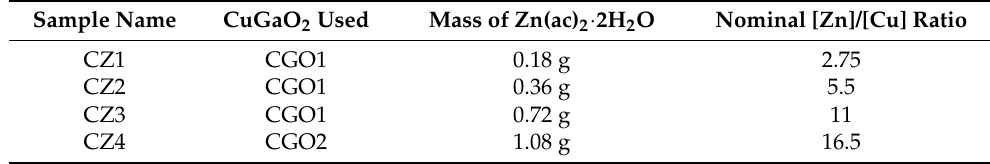
Table 1. Sample names and synthesis conditions for CuGaO 2 /ZnO hybrids. (ac = CH 3